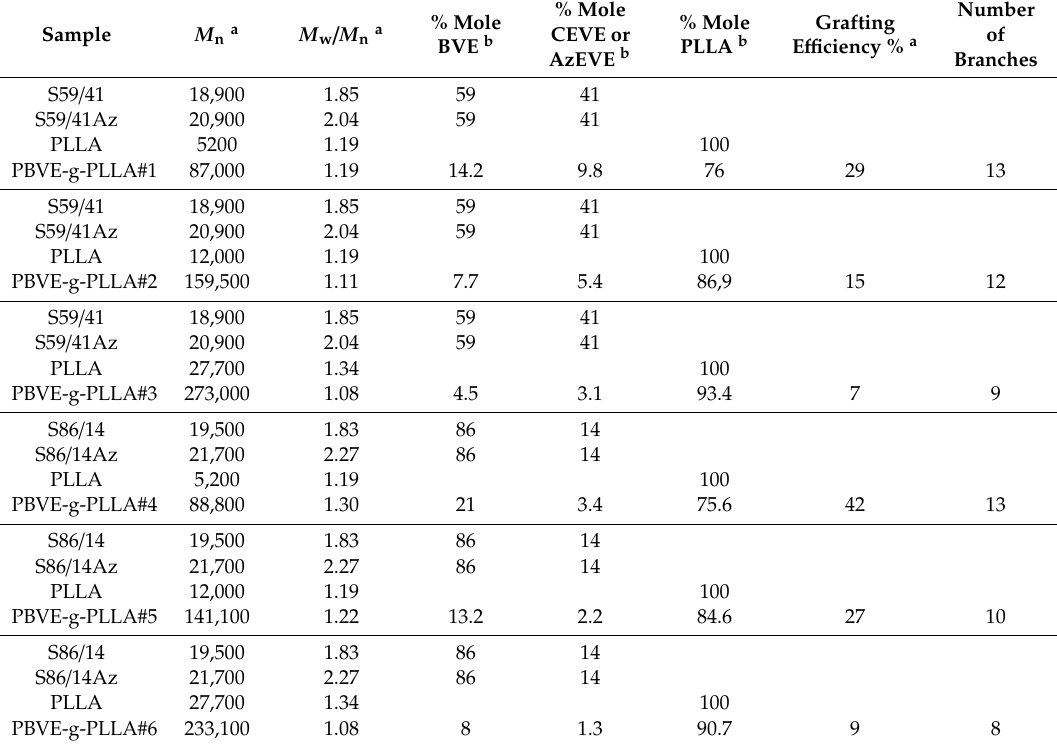
Figure 6. Monitoring the synthesis of sample PBVE– g –PCL#2 via the grafting “onto” methodology by SEC. Table 6. Molecular characteristics of the graft copolymers PBVE-g-PLLA prepared via the grafting “onto”